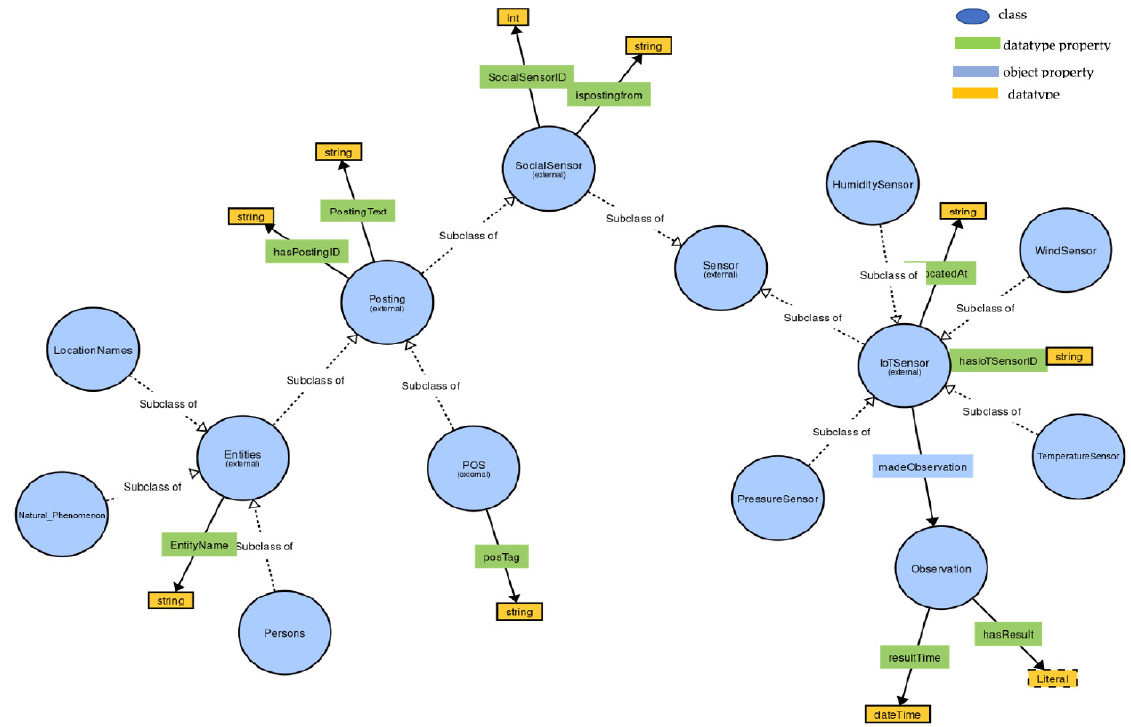
Figure 5. Classes, object, and data properties of a wind gust situation model in a combined information space. Table 5. The object properties, domain, range, and the description of main object properties in combined information